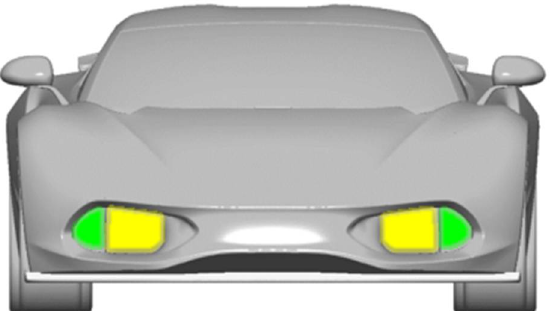
Figure 9. Front view of the car with the two sets of flow inlets at the front, inlets to the wheel chamber (green), and inlets leading the flow over the mask (yellow).